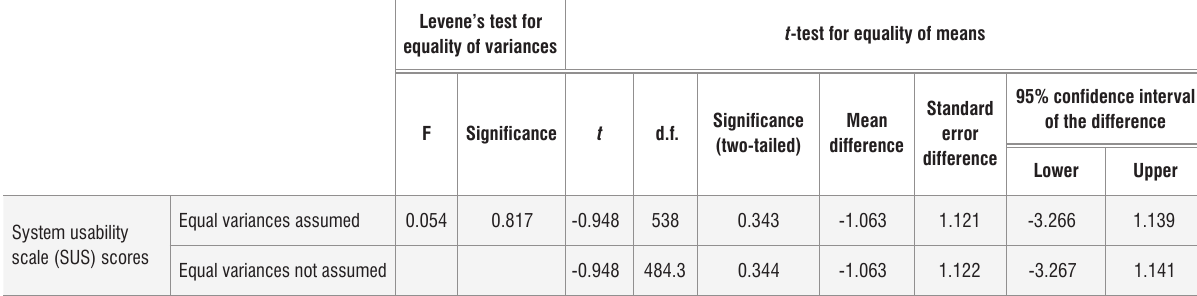
t -test for equality of means